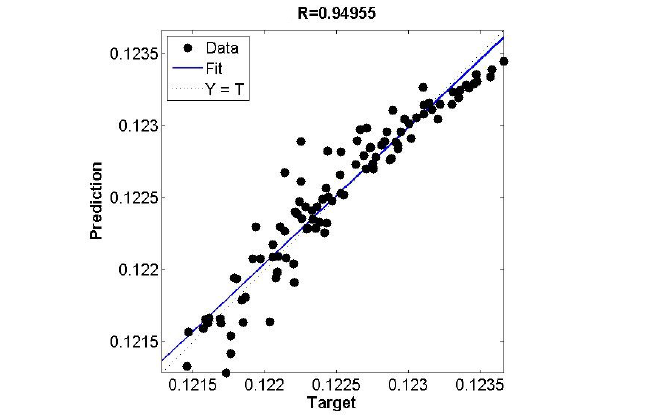
Figure 4. Ensemble model for prediction of mass flow rate (kg/s) of CO.